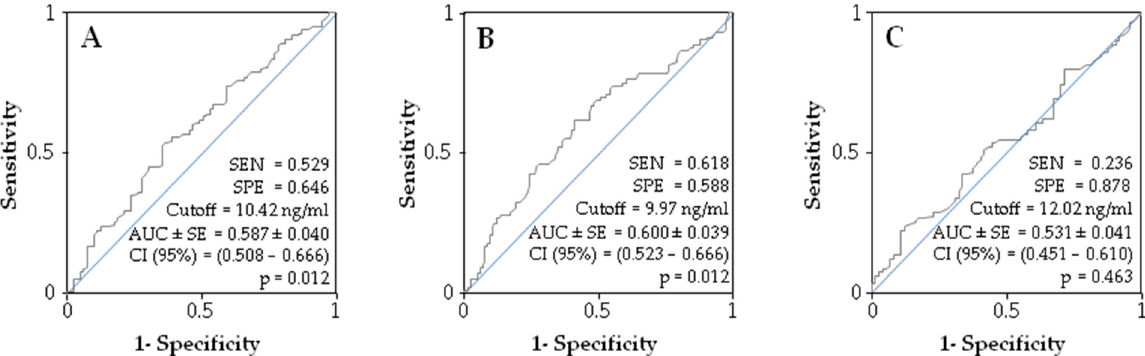
Figure 1. Medians and interquartile ranges of the serum sestrin-1 concentration (s-[Sestrin-1] (ng/mL)) in frail and non-frail participants following the Fried Frailty Phenotype ( A ), the Clinical Frailty Scale ( B ), and the Tilburg Frailty Indicator ( C ) criteria.